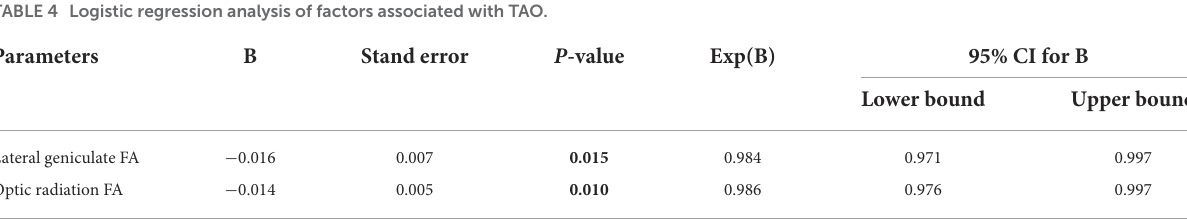
TABLE 4 Logistic regression analysis of factors associated with